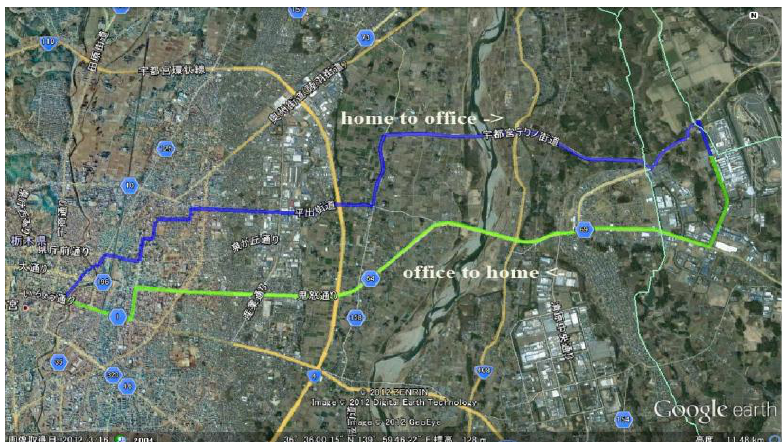
Figure 6. The actual route